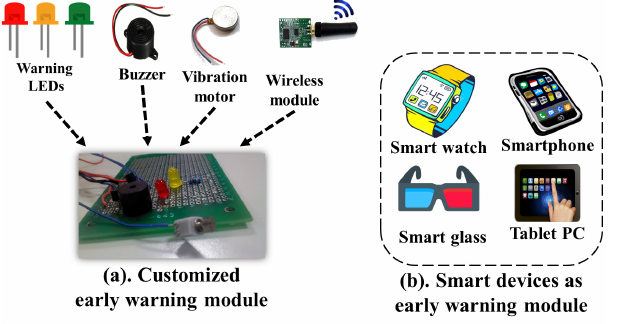
Figure 4. Possible early warning